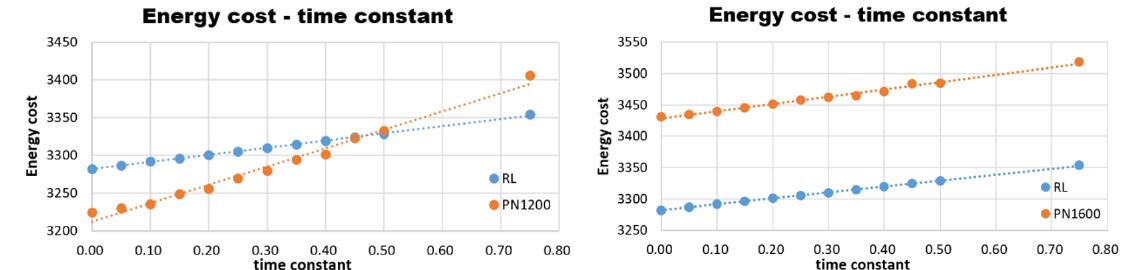
Figure 16. Energy cost trend for line-of-sight (LOS)-rate-only guidance for various 𝜏 .